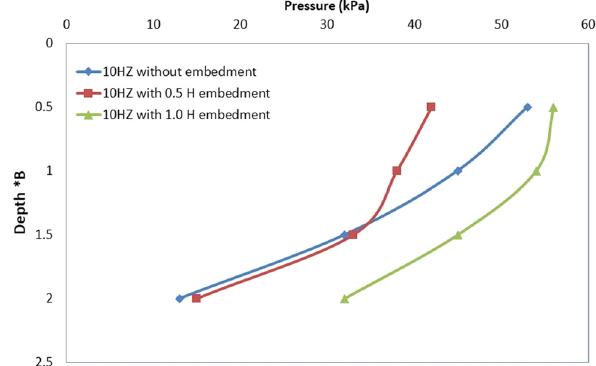
Figure 9: Relation between embedment depth and settlement under the vertical vibration ( 10 Hz ) . Figure 10: Variation in stresses in soil under vertical